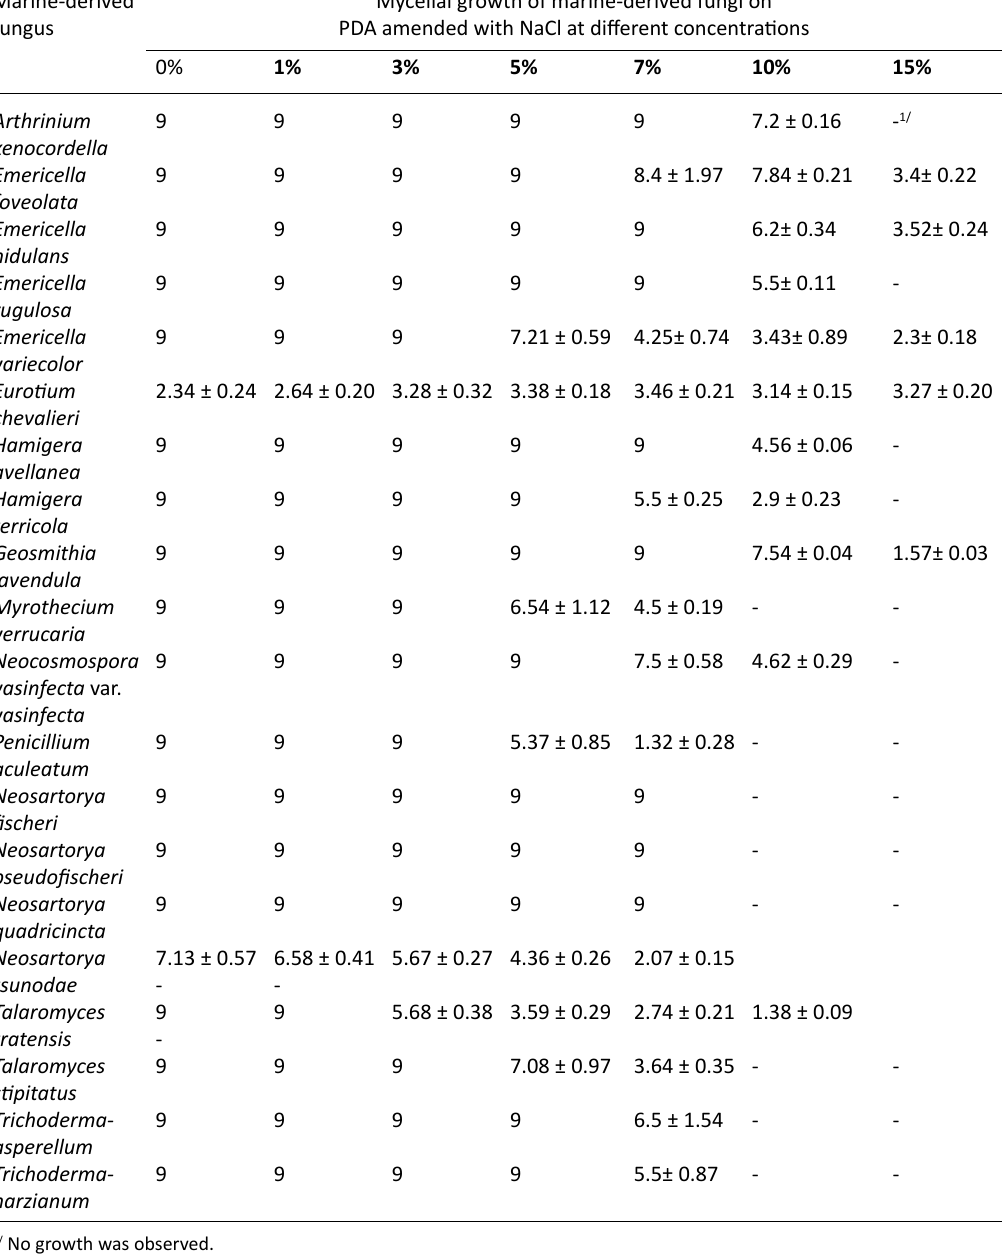
table 4. NaCl tolerance of marine-derived fungi Marine-derived Mycelial growth of marine-derived fungi